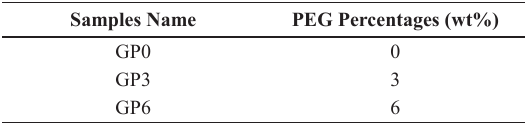
Table 1. Formulation of the three geopolymers prepared for the study.